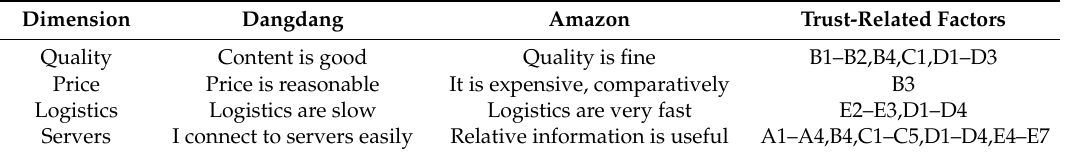
Table 3. Examples of four aspects of evaluations provided by evaluation systems of Dangdang and Amazon. Dimension Dangdang Amazon Trust-Related Factors Quality Content is good Quality is fine Price